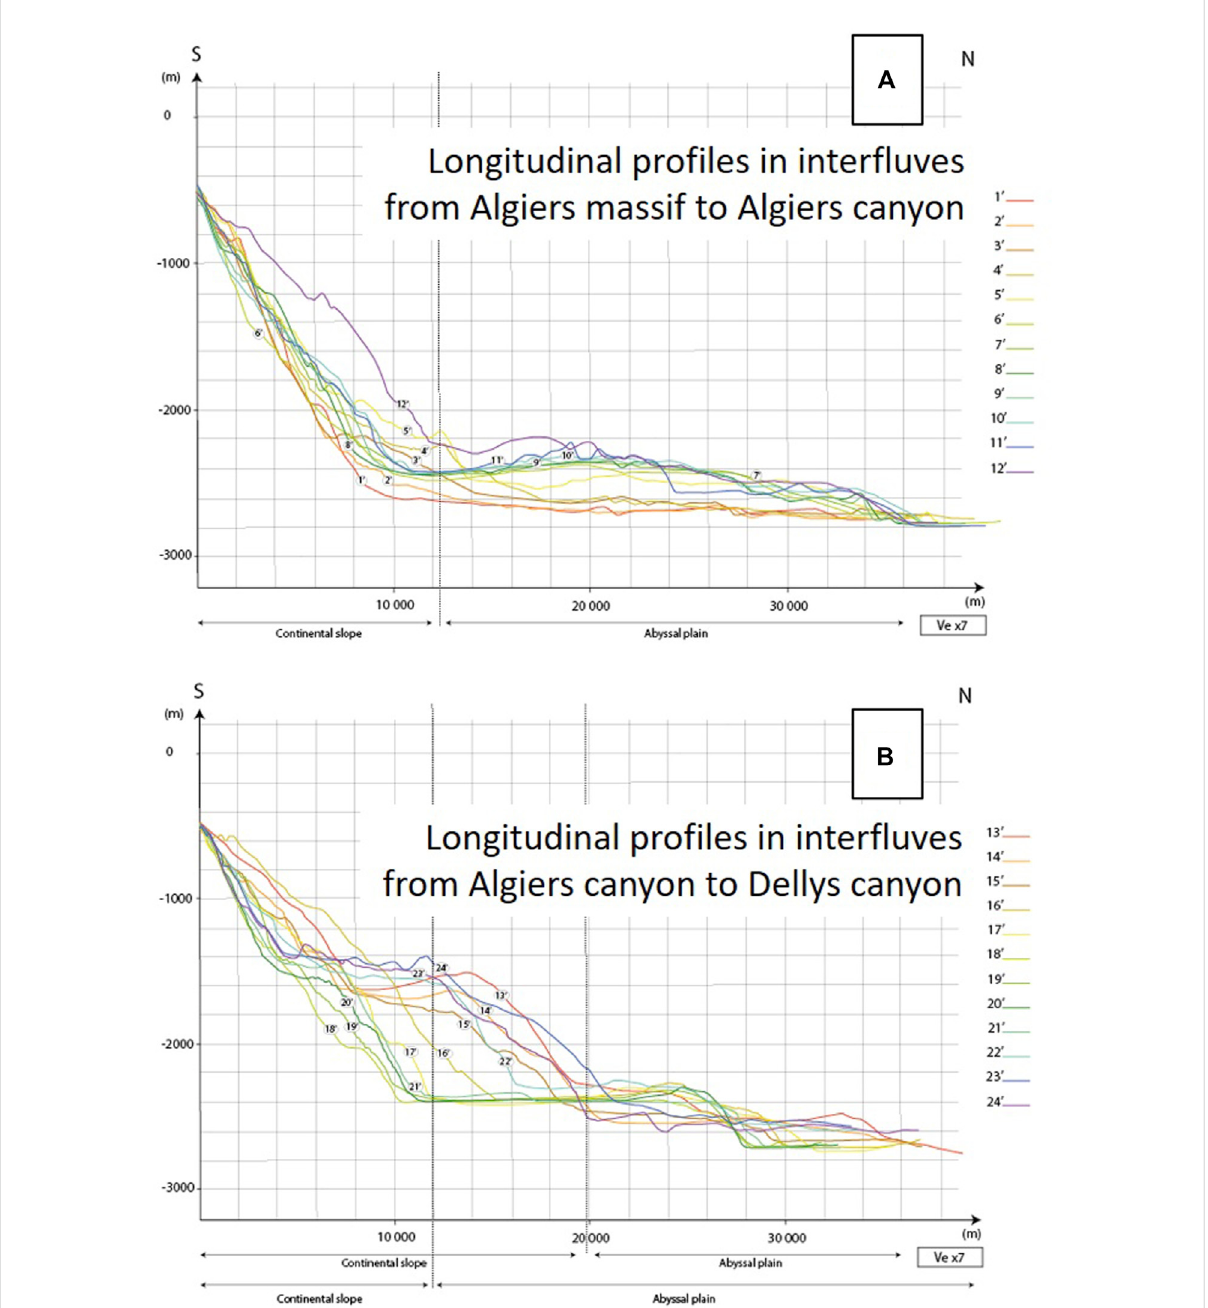
FIGURE 6 Plotsofthelongitudinalpro fi lesoutsidecanyons(inter fl uves)locatedonFigure5.Upperplot (A) :pro fi lesI1 ′ toI12 ′ ofthewesternmostsegment oftheslopestrikingW-Eandlocatedoutsidetheruptureareaofthe2003Boumerdèsearthquake(Figure2).Lowerplot (B) :pro fi lesI13 ′ toI24 ′ ofthe segment oftheslope striking N60 ° Eand locatedin frontof therupture areaofthe2003Boumerdès earthquake(Figure 2). Verticalexaggeration (Ve) of